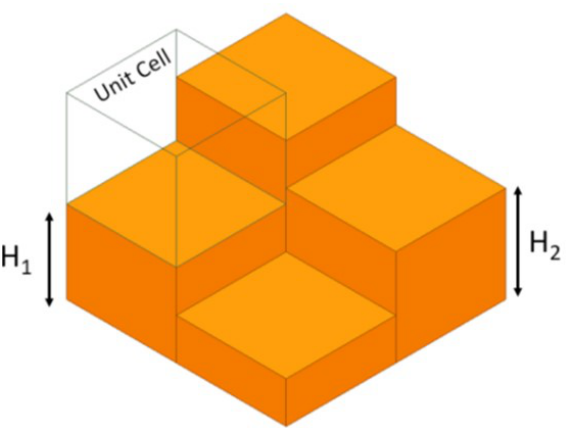
Figure 4. Reconfigurable non-resonant-type unit cell using metal blocks of variable